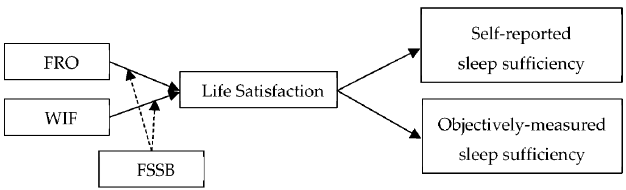
Figure 1. Research model.